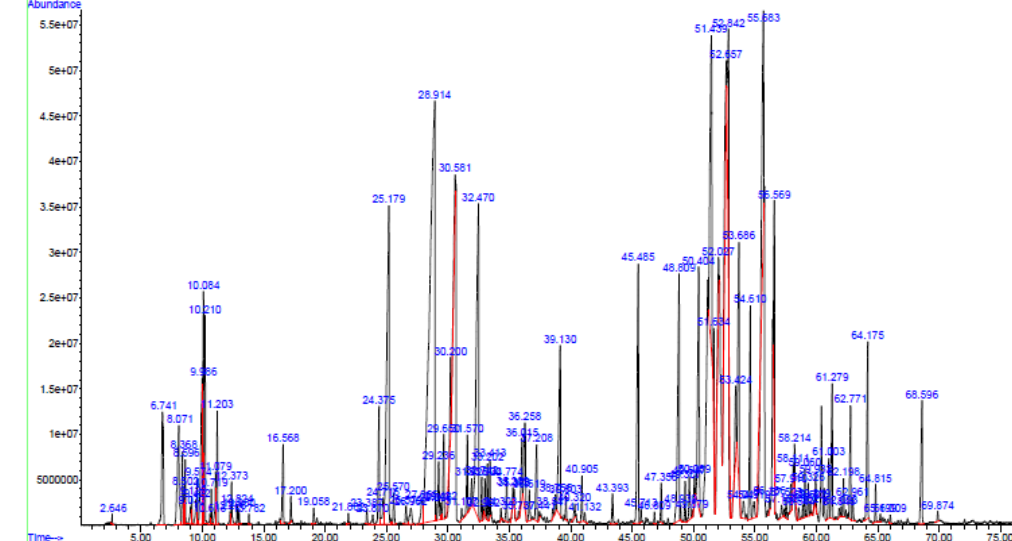
Figure 5. Gas chromatogram of the essential oil of ‘Koçarlı’ white flowers